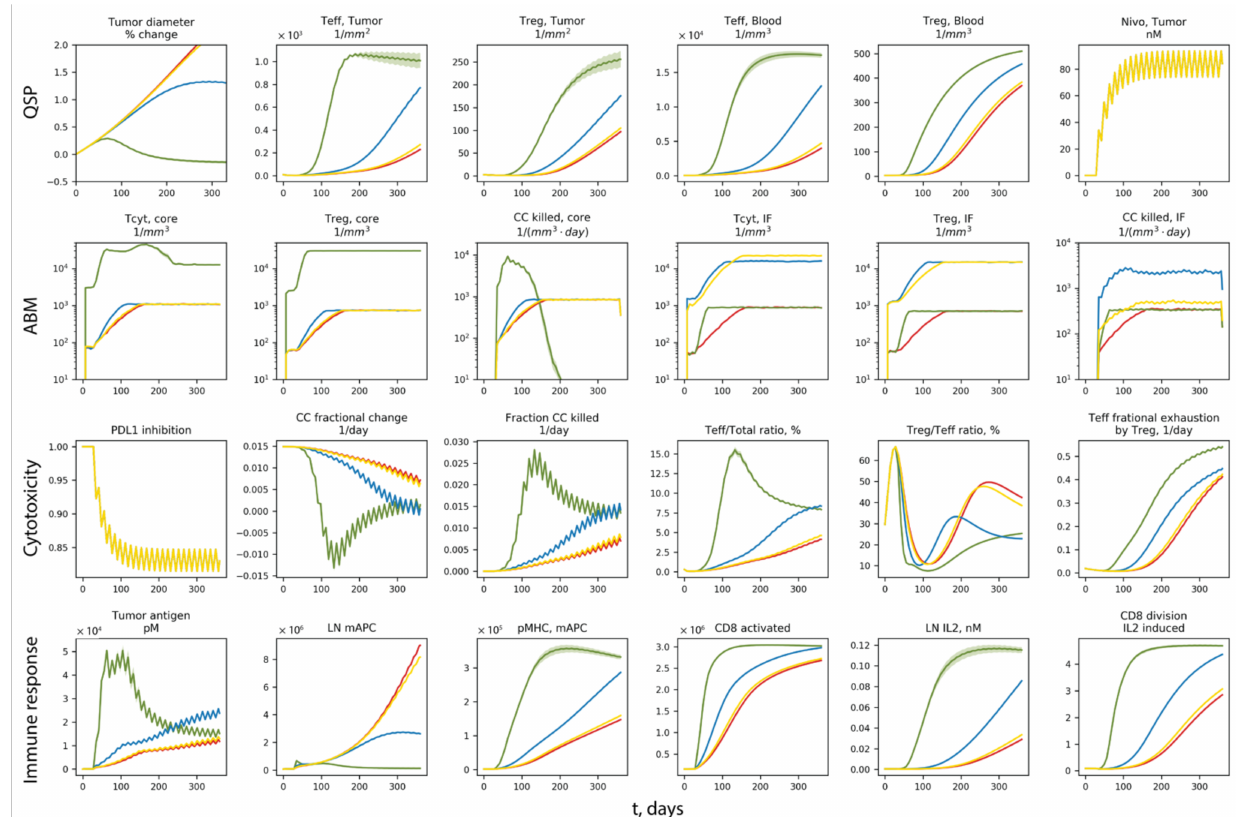
Figure 8. Tumor dynamics with different vascular densities in various sub-regions of tumor. Red: baseline vascular densities. Green: increased vascular density in the tumor core. Blue: increased vascular density in tumor at the invasive front. Yellow: increased vascular density in normal tissue outside of the invasive